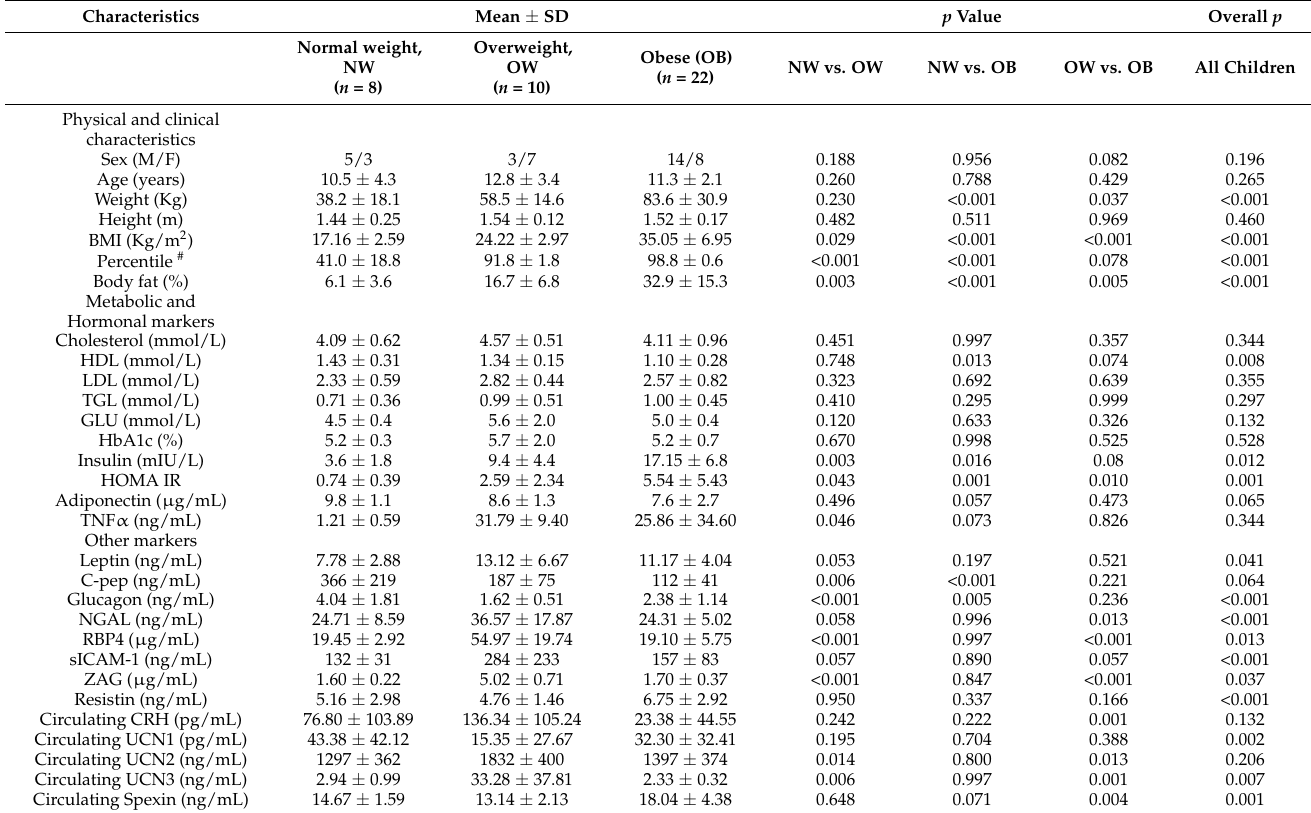
Table 1. Characteristics of the study